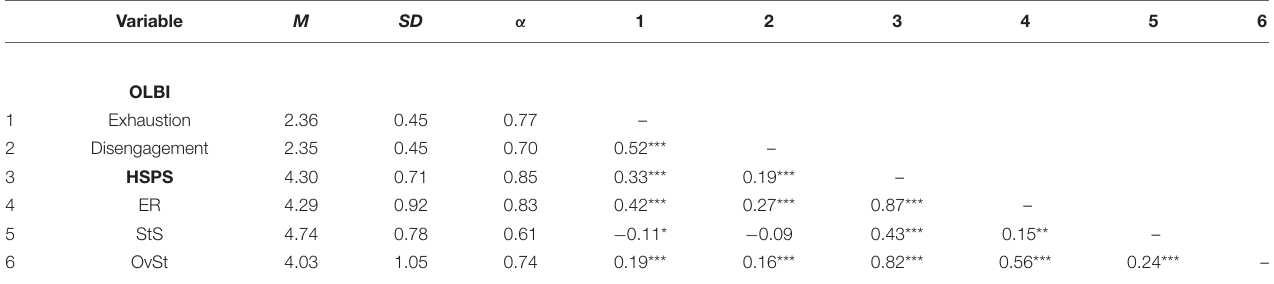
TABLE 5 | Descriptive statistics, Cronbach alpha, and the results of Spearman’s rho correlation between the scores of the Oldenburg Burnout Inventory (OLBI) and the Highly Sensitive Person Scale (HSPS). Variable M